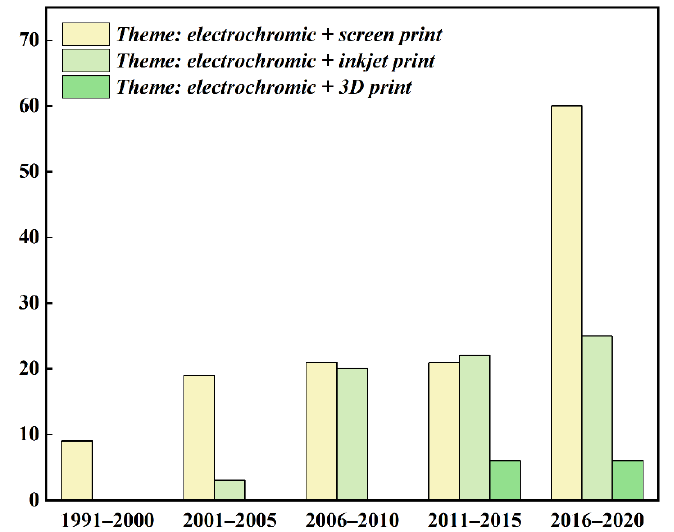
Figure 1. Distribution of patents for papers published in the web of SCI over the years for different printing methods of electrochromic coverage .